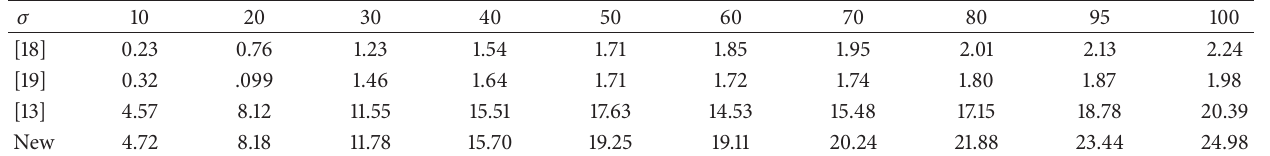
Table 8: IEF of different algorithms with different Gaussian noise levels for Tennis video